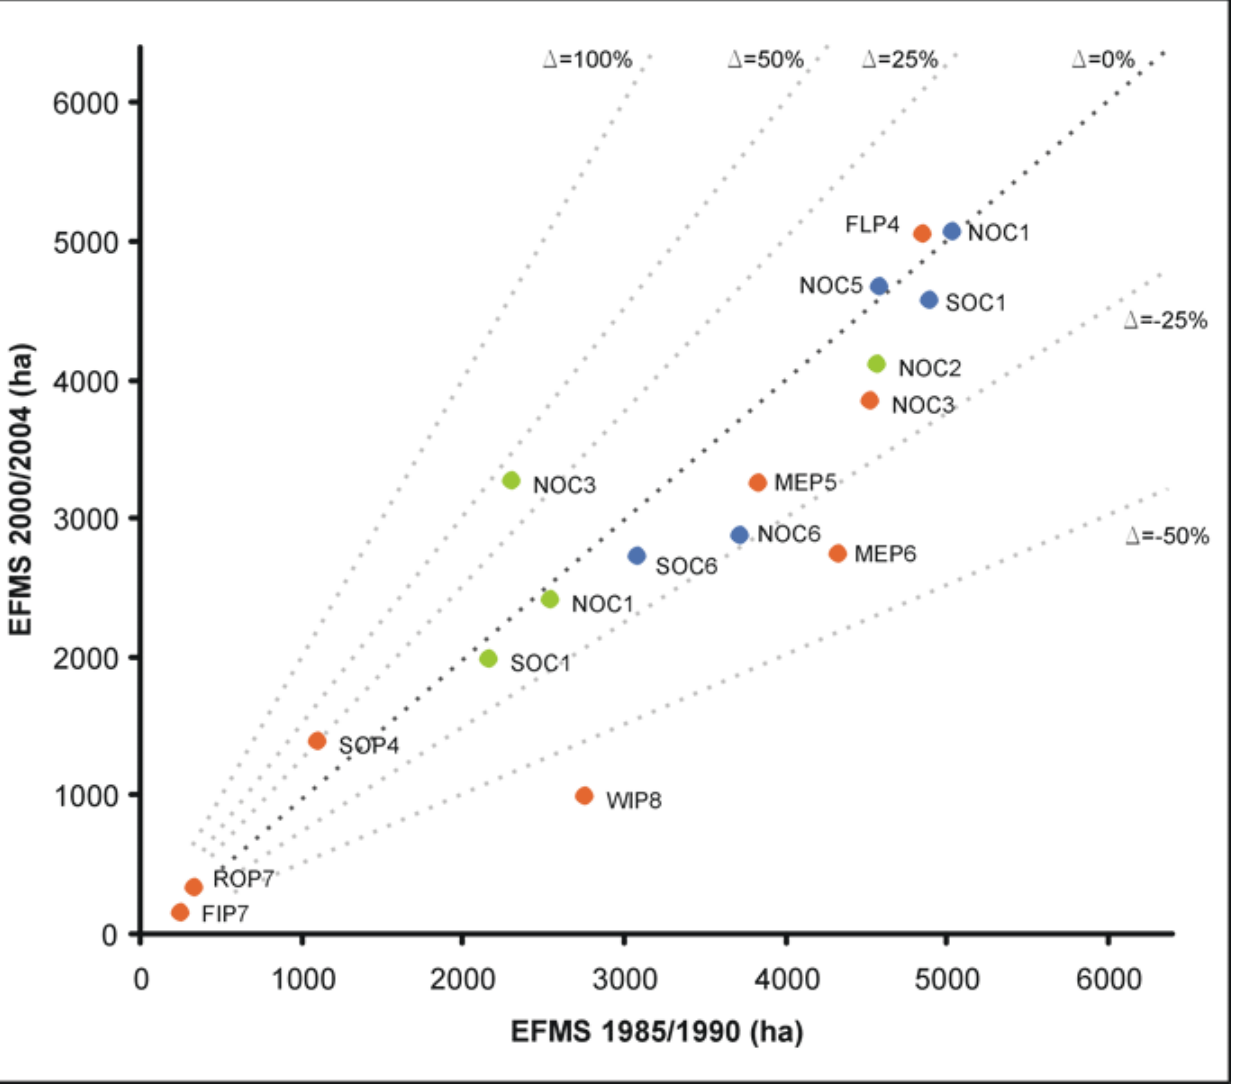
Fig. 4. Effective mesh size (EFMS) for 1985–1989 and 2002–2004 for grassland discriminated by pilot area, subunit, and country. Dotted lines indicate the thresholds of relative change in EFMS, calculated as D - Y = 100( Y )/ Y , where Y is the EFMS. The abbreviations indicate the subunit (letters) relative final initial initial and pilot area (Landsat scene; numerals): NOC = Northern Campos, SOC = Southern Campos, SOP = Southern Pampa, FLP = Flooding Pampa, WIP = West Inland Pampa, FIP = Flat Inland Pampa, MEP = Mesopotamic Pampa, ROP = Rolling Pampa, 1 = 222/083, 2 = 223/081, 3 = 224/080, 4 = 224/086, 5 = 225/082, 6 = 225/083, 7 = 227/083, and 8 = 229/084. The number of grid cells included in each combination is given in Table